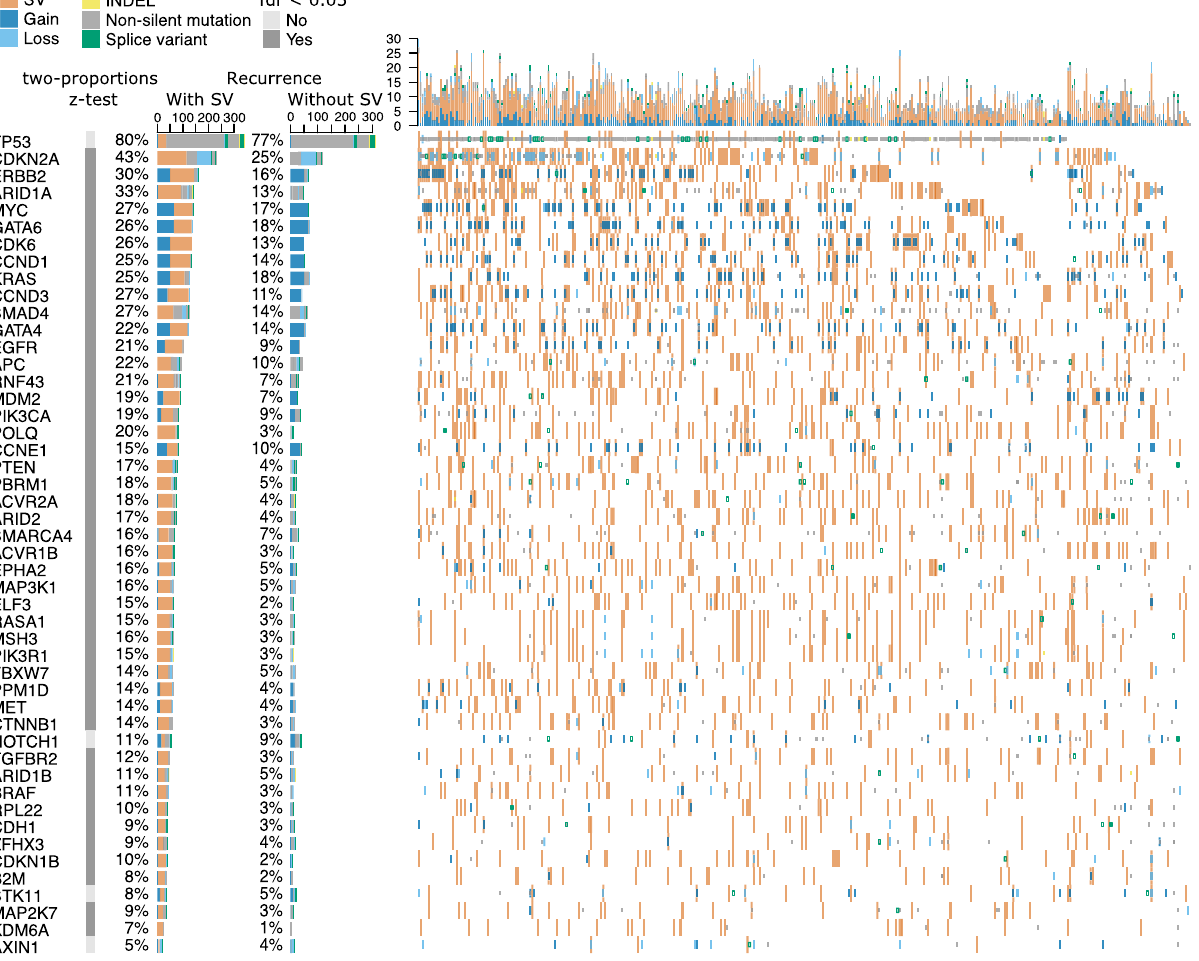
Fig. 3 Estimates of recurrence in known driver alterations with and without SVs. Oncoplot showing recurrence of known OAC driver gene mutations (taken from Frankell et al., 2019 and Campbell et al., 2020) with and without SV. Estimates of recurrence without SVs includes copy number gains and losses, INDELs and SNVs. Recurrence with SVs are counted when the interval between two breakpoints overlaps with exon or exons of the gene. Two- proportions z -test with multiple hypothesis testing (FDR) used to test if recurrence is signi fi cantly higher with SVs